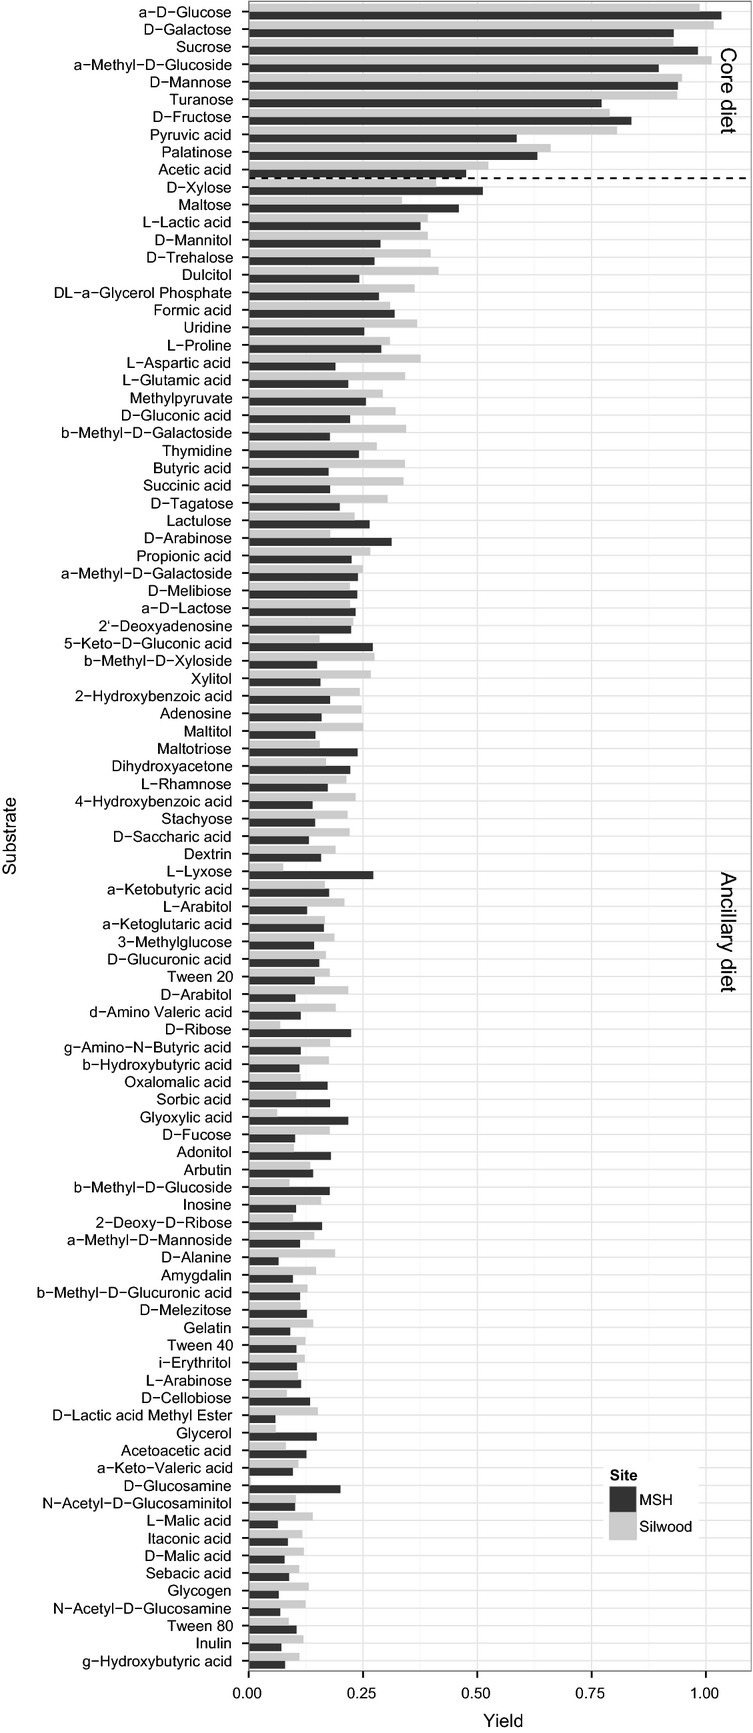
Rank distribution of yield among substrates. The bar plot shows yield for the 95 most efficiently utilized substrates in the MSH (black) and Silwood (gray) surveys. Ten substrates are clearly identified by the ability of isolates to reach higher yields on these substrates. The core diet can also be identified by the fact that all isolates in both locations achieve higher yield on these substrates (Fig.6).